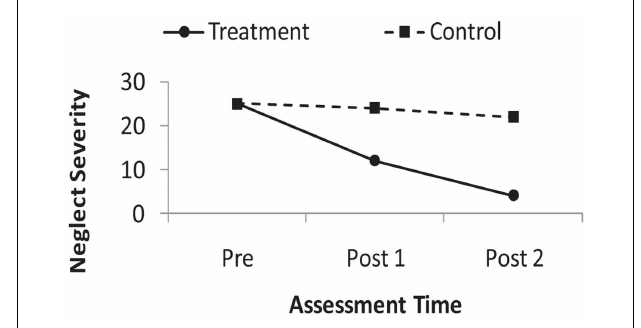
FIGURE 2 | Depiction of fictional, idealized recovery trajectories in the control, and treatment groups of a neglect rehabilitation study . Larger values on the y -axis indicate more severe